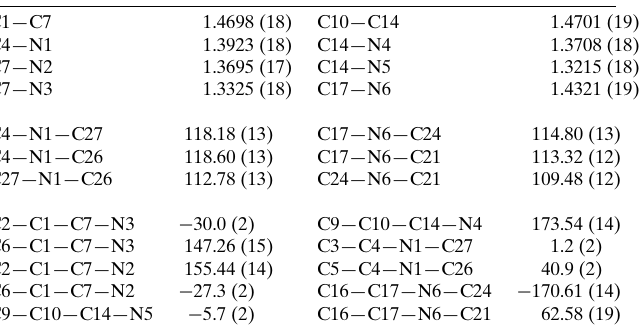
Table 1 Selected geometric parameters (A˚ , (cid:3) ) for (1) (cid:2) 2H 2 O. C1—C7